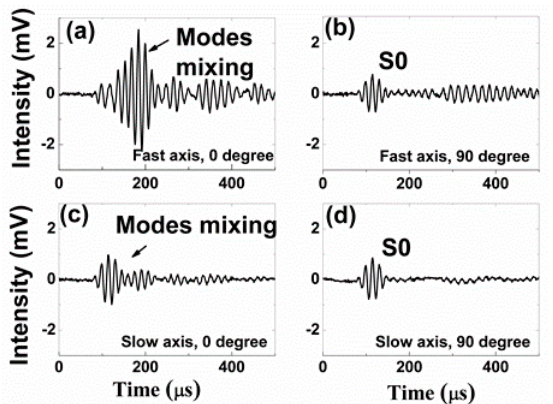
Figure 5. Responses of the Polarization-maintaining Fiber Bragg grating under 30 kHz actuation to ( a ) 0-degree excitation and fast-axis detection; ( b ) 90-degree excitation and fast-axis detection; ( c ) 0-degree excitation and slow-axis detection; and ( d ) 90-degree excitation and slow-axis detection.